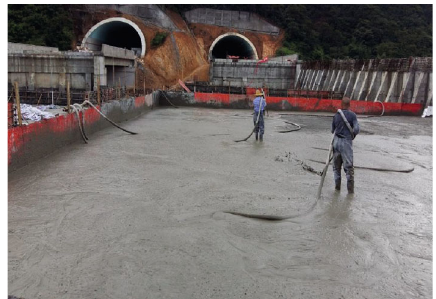
Figure 1: Use of lightweight foamed concrete as a fi ller behind buttressed earth-retaining